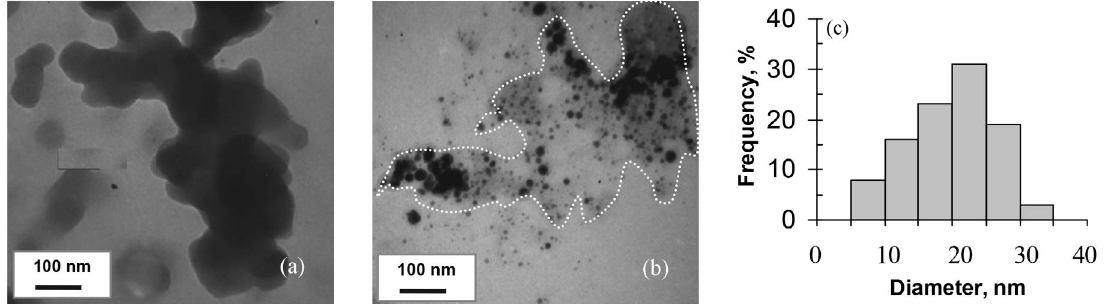
Fig. 2. The TEM images of PTHQ (a), AgNPs (b) and the corresponding size distribution histograms of AgNPs stabilized by PTHQ (c). The borders of the PTHQ globule are shown by the dotted line in part (b).